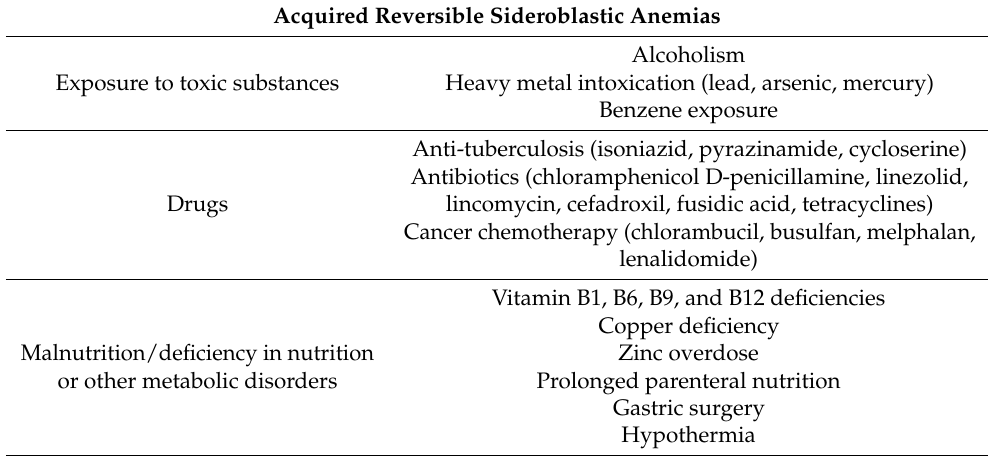
Table 3. Classification of acquired sideroblastic anemias.